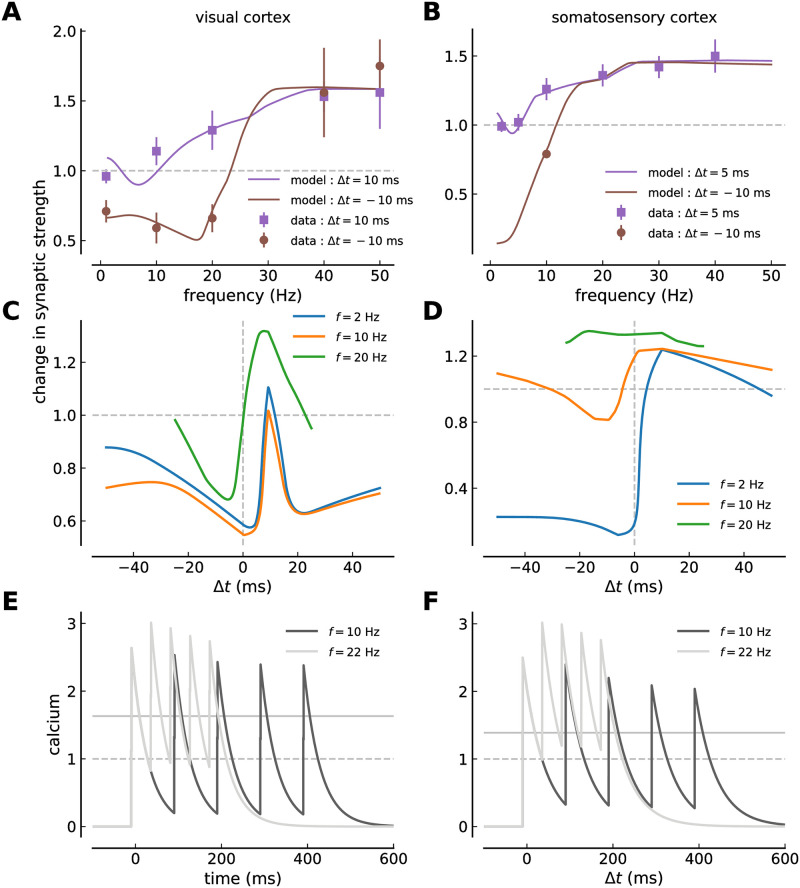
Calcium-based plasticity model with short-term depression fitted to visual- and somatosensory cortex plasticity data.(A, B) The change of the synaptic strength is shown as a function of the spike-pair presentation frequency for regular pre-post pairs (Δt = 10 ms in A and Δt = 5 ms in B, purple squares and lines), and regular post-pre pairs (Δ t = −10 ms in both panels, brown circles and lines). The data-points are taken from plasticity experiments in visual cortex slices (A, mean ± SEM, [2]) and somatosensory cortex slices (B, mean ± SEM, [3]). The solid lines show the model fit to the experimental data. (C, D) Change in synaptic strength as a function of the time lag between pre- and postsynaptic spikes for regular spike-pairs at three different spike-pair presentation frequencies (given in panel) in visual- (C) and somatosensory cortex (D). (E, F) Calcium traces during regular post-pre spike-pair stimulation for the visual- (E) and somatosensory data-set (F). Five spike-pairs with Δt = −10 ms are presented at the frequency given in the panel. The full and the dashed gray lines indicate the area-specific thresholds for potentiation and depression, respectively.